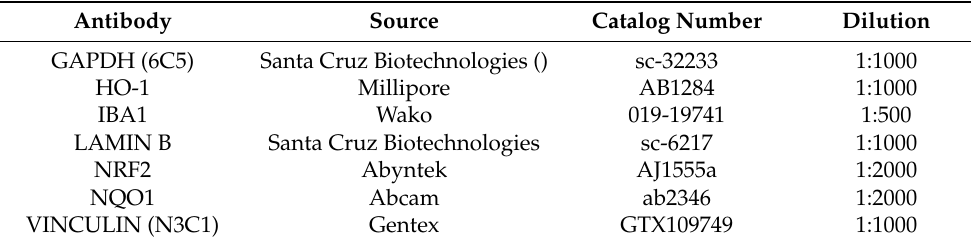
Table 3. List of antibodies used in this